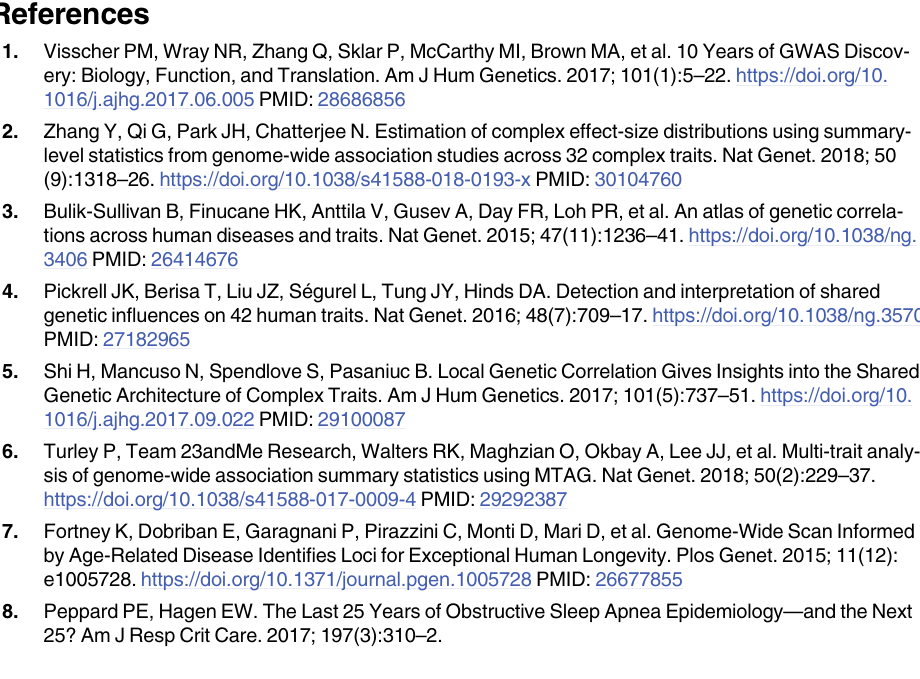
S6 Table. Sample sizes of validation cohorts used for the replication study. S7 Table. Full results of pleiotropy tests between eQTLs and OSA traits in three known OSA GWAS loci at the eQTL p -value <